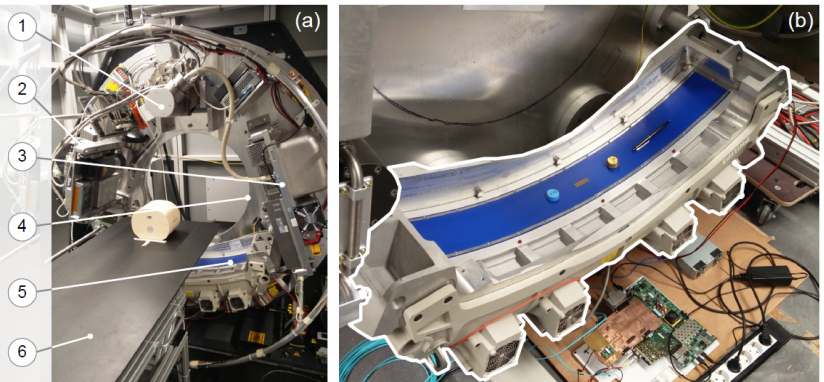
Figure 7. Components of our open-interface CT system. ( a ) Complete experimental CT system with (1) X- table. ( b ) Detailed view of the DMS and CCU implemented on the Xilinx ZC706 Evaluation Kit.